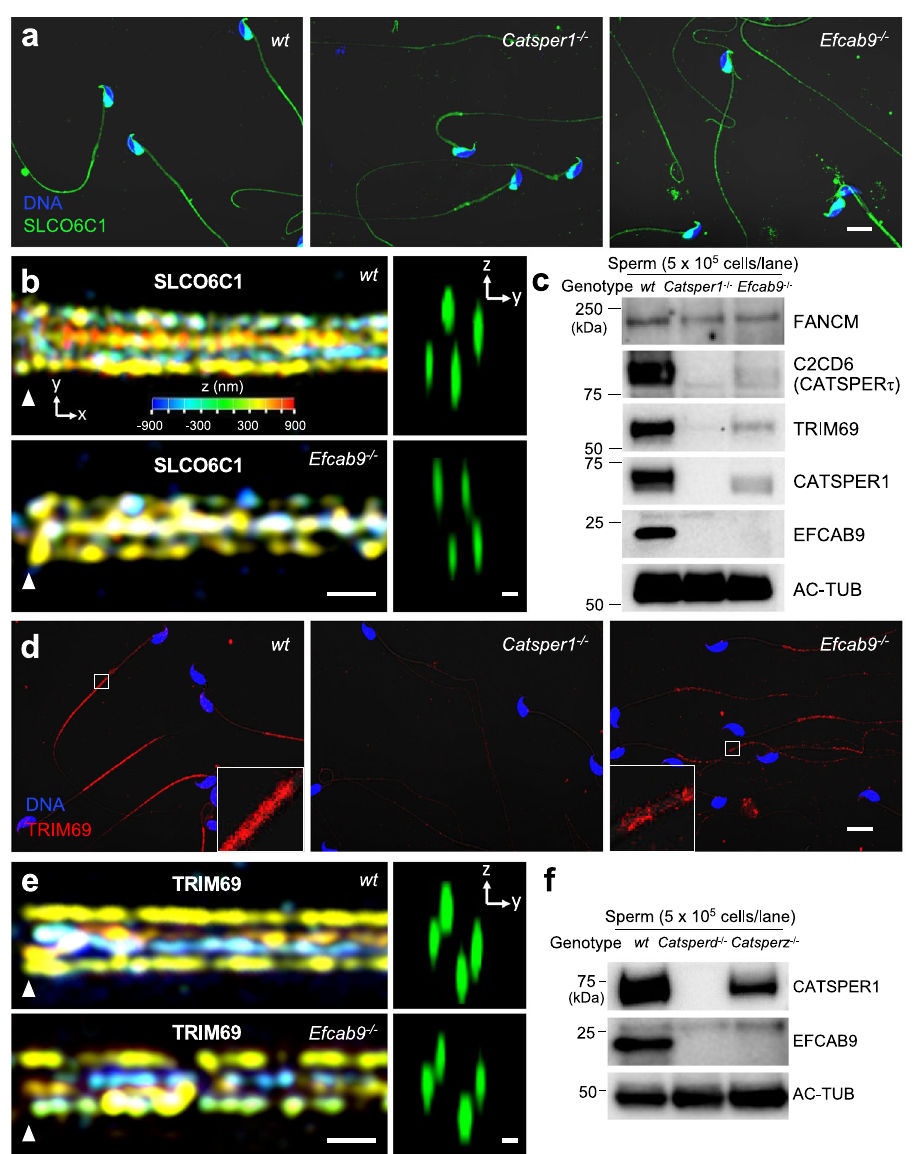
Fig. 4 Subcellular localization and protein levels of candidate CatSper-associated proteins in mouse sperm. a Immunolocalization of SLCO6C1 in mouse wild type, Catsper1 − / − and Efcab9 − / − sperm by confocal light microscopy. Sperm heads are stained blue using Hoechst. b Quadrilinear arrangements of SLCO6C1 visualized by 3D structured illumination microscopy (SIM) in sperm from wild type (upper) and Efcab9 − / − (lower) mice. Colors in xy projections encode the relative distance from the focal plane along the z axis. Arrowheads indicate the annulus, i.e., the junction between the midpiece and principal piece of the sperm tail. yz projections (cross sections) are shown on the right. c Western blot analyses of three candidate CatSper-associated proteins, FANCM, C2CD6 and TRIM69, in wild type and two CatSper mutants. d Immunolocalization of TRIM69 in mouse wild type, Catsper1 − / − and Efcab9 − / − sperm by confocal light microscopy. Sperm heads are stained blue using Hoechst. e Quadrilinear arrangements of TRIM69 visualized by 3D SIM in sperm from wild type (upper) and Efcab9 − / − (lower) mice. f Western blot analyses of EFCAB9 in wild type, Catsperd − / − and Catsperz − / − sperm. Scale bars, 10 μ m in ( a and d ); 500 nm in xy projection (left) and 200 nm in yz projections (right) of ( b and e ). All shown images are representative images from three biological and technical replicates ( n =